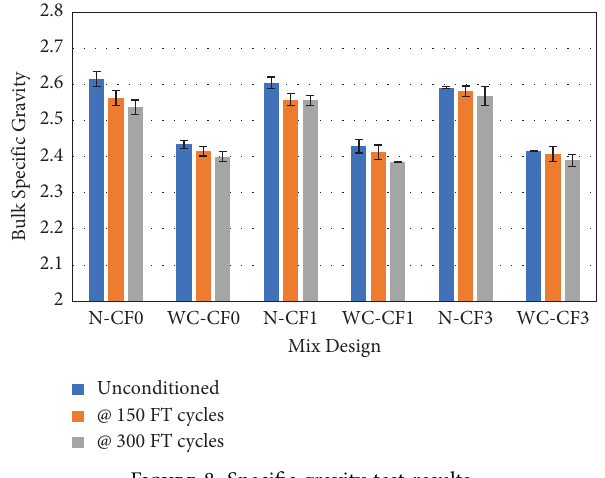
Figure 8: Specifc gravity test results.